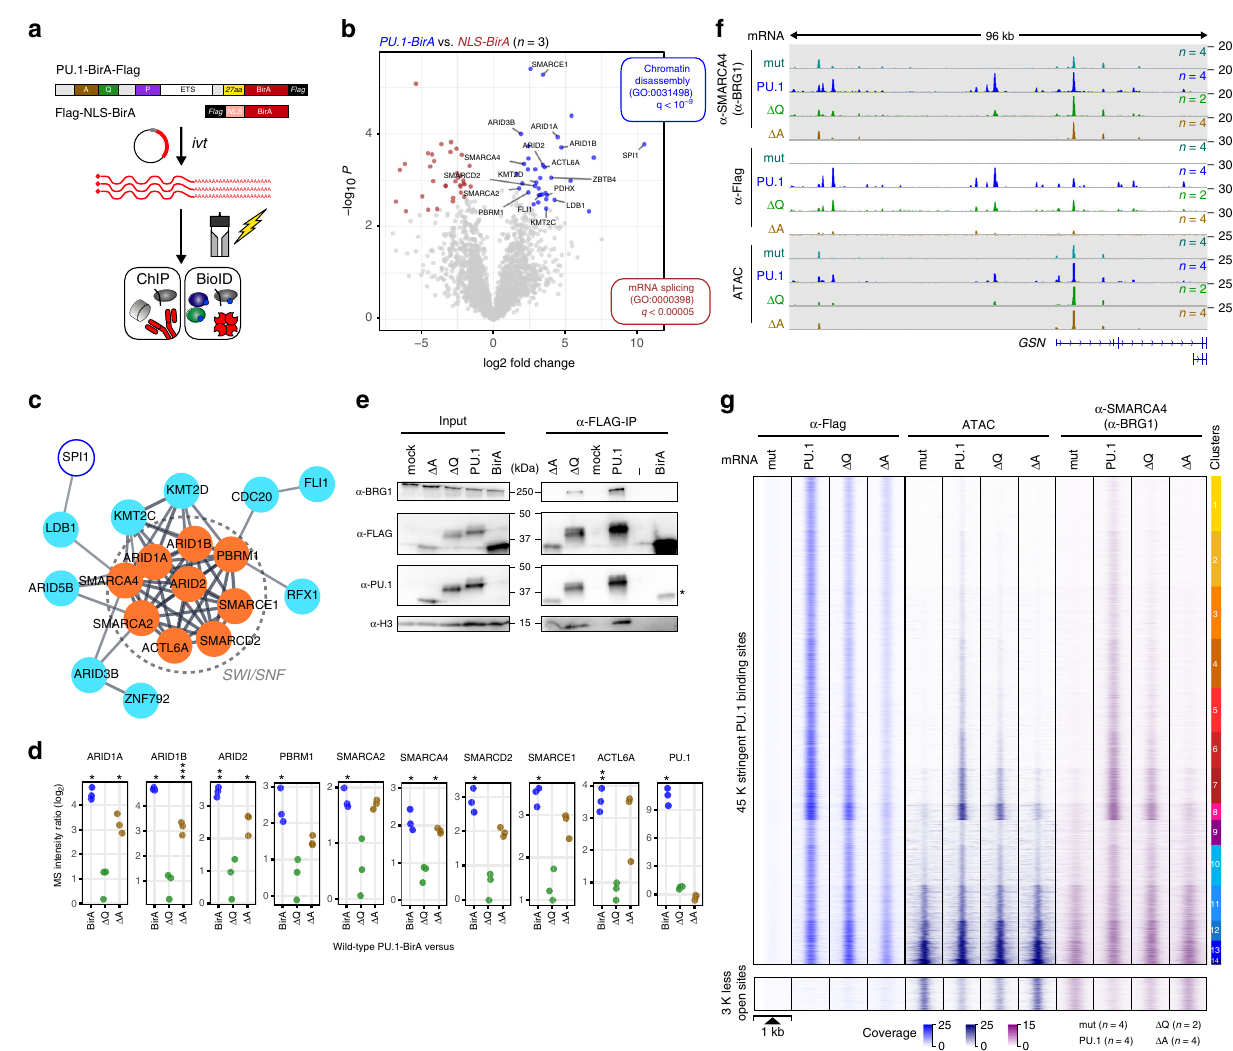
Fig. 8 Identi fi cation of PU.1 proximal proteins using BioID. a Schematic of the experimental setup. b Volcano plot illustrating proteins signi fi cantly enriched in PU.1-BirA-mRNA-transfected CTV-1 cells compared with NLS-BirA-mRNA-transfected control cells. Blue dots represent proteins with FDR < 0.05 and log fold change (logFC) > 2. Only PU.1-speci fi c proteins of GO terms for chromatin organization and interesting transcriptional regulators are highlighted. c STRING analysis illustrating the functional protein association network. The network view summarizes predicted associations for proteins signi fi cantly enriched in the PU.1-BioID. The network nodes represent the proteins, the edges represent predicted functional associations. Only connected nodes are shown. d Dot plots showing the enrichment of peptides (ratios of log 2 -transformed normalized iBAQ values) representing the indicated SWI/ SNF components (PU.1/ SPI1 is shown as a control) in BioIDs from PU.1-BirA vs. NLS-BirA (control), Δ Q-BirA, or Δ A-BirA-mRNA-transfected CTV-1 cells (*** P < 0.001; ** P < 0.01; * P < 0.05; paired t -test, permutation-based correction). e Immunoblotting of α FLAG mAb immunoprecipitations (5 h after electroporation, IP 5 h), along with corresponding input lysates of control (mock), PU.1, Δ Q, Δ A, and BirA-mRNA-transfected cells using the indicated antibodies. f IGV genome browser tracks for the GSN locus showing SMARCA4 (BRG1) and PU.1 ChIP-seq, as well as ATAC-seq coverage in control (mutPU.1, gray – green)-, PU.1 (blue)-, Δ Q mutant (green)-, and Δ A mutant (lightbrown)-expressing cells. g Distribution of the PU.1 ChIP-seq, ATAC-seq signal, and SMARCA4 (BRG1) ChIP-seq signals in control (mutPU.1), PU.1, Δ Q, and Δ A mRNA-transfected cells across the 45 K clustered PU.1-binding sites, as well as the disappearing ~3 K sites that were accessible prior to PU.1 induction. b – e , g Source data are provided as a Source Data fi differentiation of MOs into MACs or DCs were performed as described (Biochrom), 1mM sodium pyruvate (Sigma), 50Uml − 1 penicillin/streptomycin, 0.4× previously 9,35,36 . B cells were puri fi ed as described 37 . Neutrophils were puri fi ed from vitamins (Sigma), 1× non-essential amino acids (Sigma), 50 μ M b-mercaptoethanol (Gibco), and 10% or 15% (TALL1) heat-inactivated fetal calf serum (FCS) (Gibco) at whole blood after lysis of erythrocytes with ACK (Ammonium-Chloride-Potassium) 37°C, 5% CO 2 , 95% humidity. Cells were split every 2 – 3 days and resuspended in lysis buffer (5ml per ml blood of 155mM NH 4 Cl, 100mM KHCO 3 , 0.1mM EDTA) fresh medium. Adherent HepG2 cells were detached using 1× Trypsin-EDTA and puri fi ed by fl uorescence-activated cell sorting (FACS) based on size and granu- (Thermo Fisher Scienti fi c). After 20 passages, cells were discarded and a new batch of larity. Human mast cells were puri fi ed from the skin that was obtained from cosmetic cells was used. For differentiation of THP-1 cells into MAC-like cells PMA (10 − 8 M; breast-reduction surgeries 38 with informed consent of the patients. Mast cell pre- Calbiochem) and 1,25-dihydroxyvitamin D3 (VD3, 10 − 7 M; Sigma) were added, cells parations were performed in compliance with the Helsinki Declaration and were approved by the ethics committee of the Charité Universitätsmedizin Berlin (reference were incubated for 3 days at 37°C, 5% CO 2 , 95% humidity, and adherent cells were number EA1/204/10). detached using Accutase solution (Sigma). Collection of blood cells from healthy donors was performed in compliance with the Helsinki Declaration. All donors signed an informed consent. The leukapheresis procedure and subsequent puri fi cation of Transfection of in vitro transcribed mRNA . Synthetic DNA templates (gBlocks) hematopoietic cell types were approved by the local ethical committee (reference number 12-101-0260). Separation of peripheral blood cell types and in vitro for wild-type PU.1, it ’ s mutated version, all PU.1-deletion mutants, and all BirA*